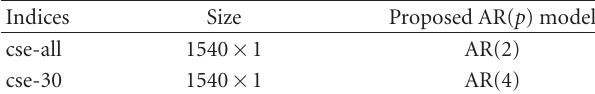
Table 1: Data description and proposed